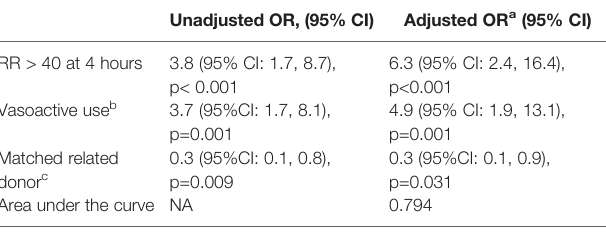
TABLE 3 | Multivariate model for the association of patient characteristics with NIPPV